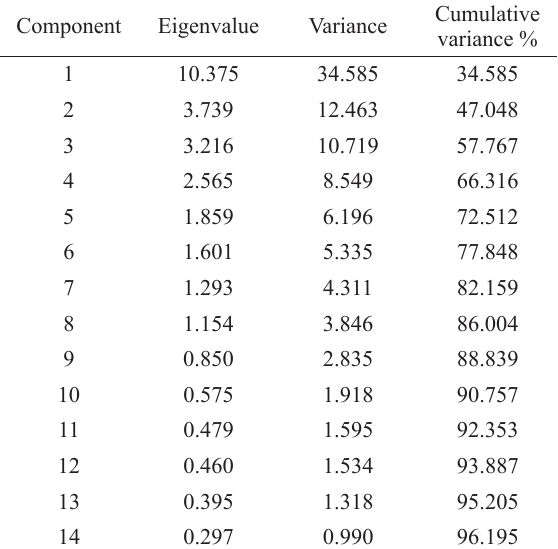
Eigenvalues of PCA for water metal analysis datasets.